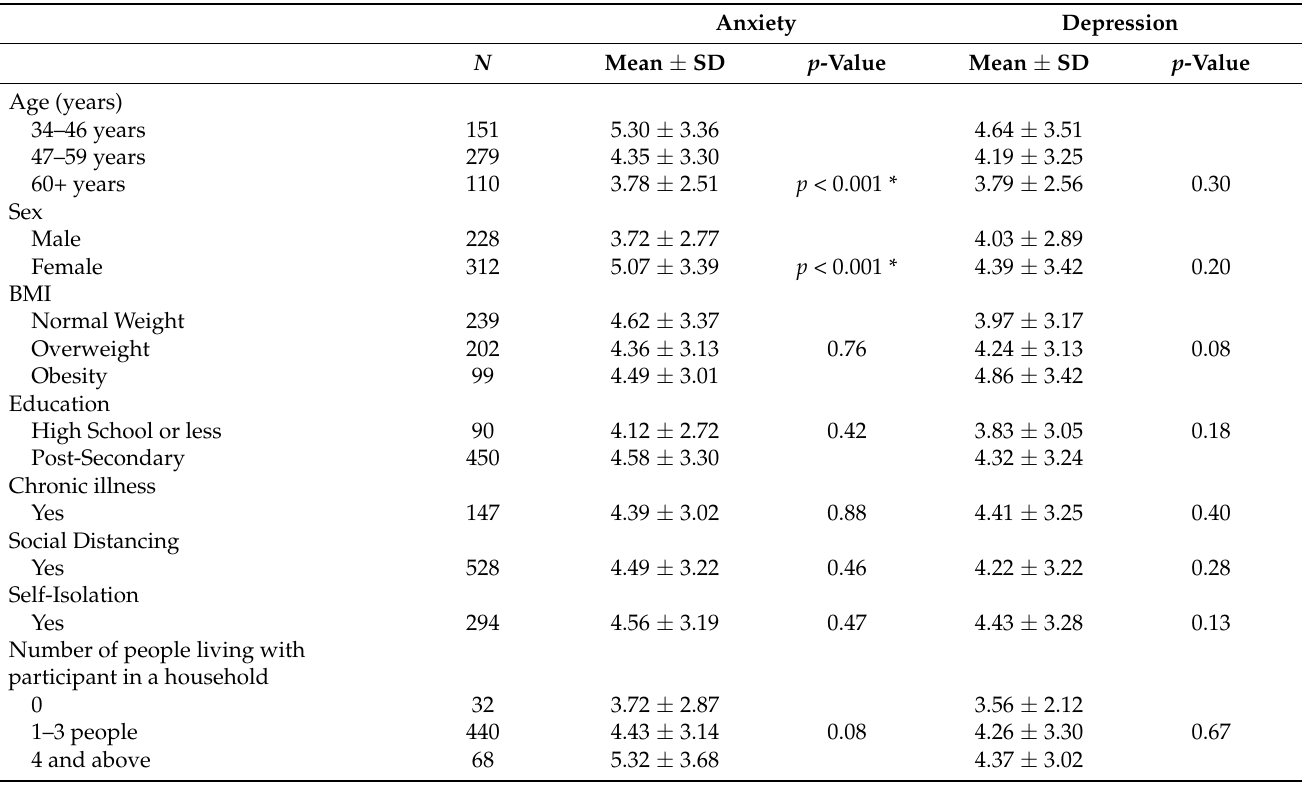
Table 2. Description of the samples stratified by mean anxiety and depression